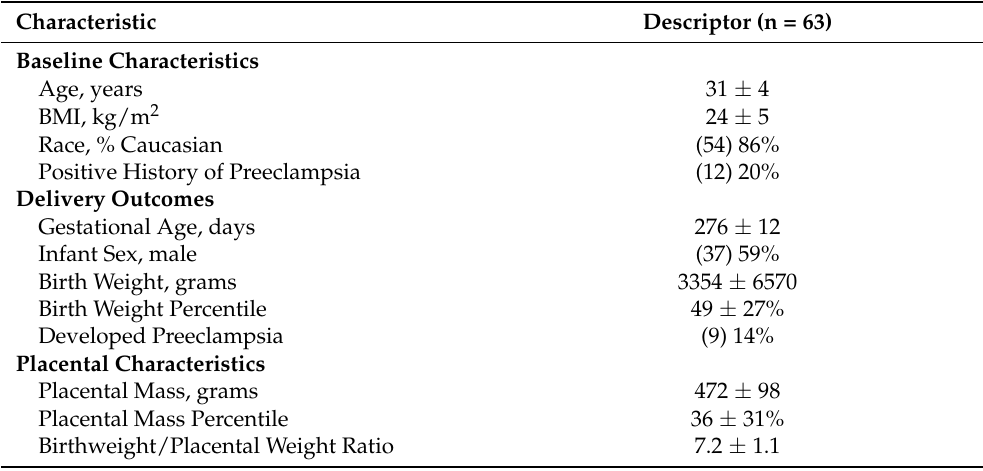
Table 1. Prepregnancy demographics, birth outcomes, and frequency of placental evidence of MVM lesions. Data is presented as mean ± standard deviation or (number)